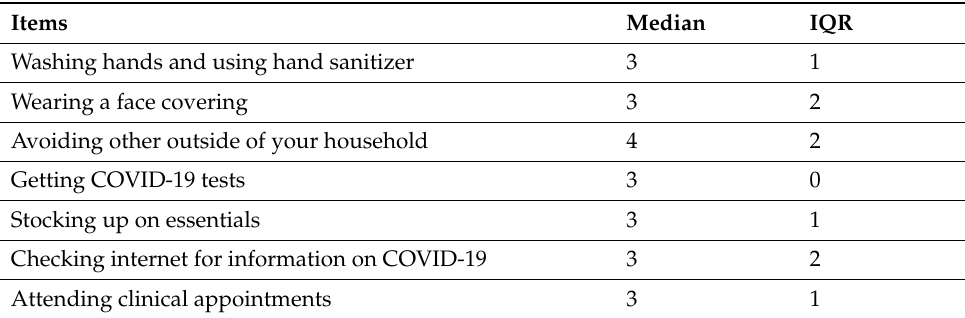
Table 5. Medians of COVID-19 behaviour scale